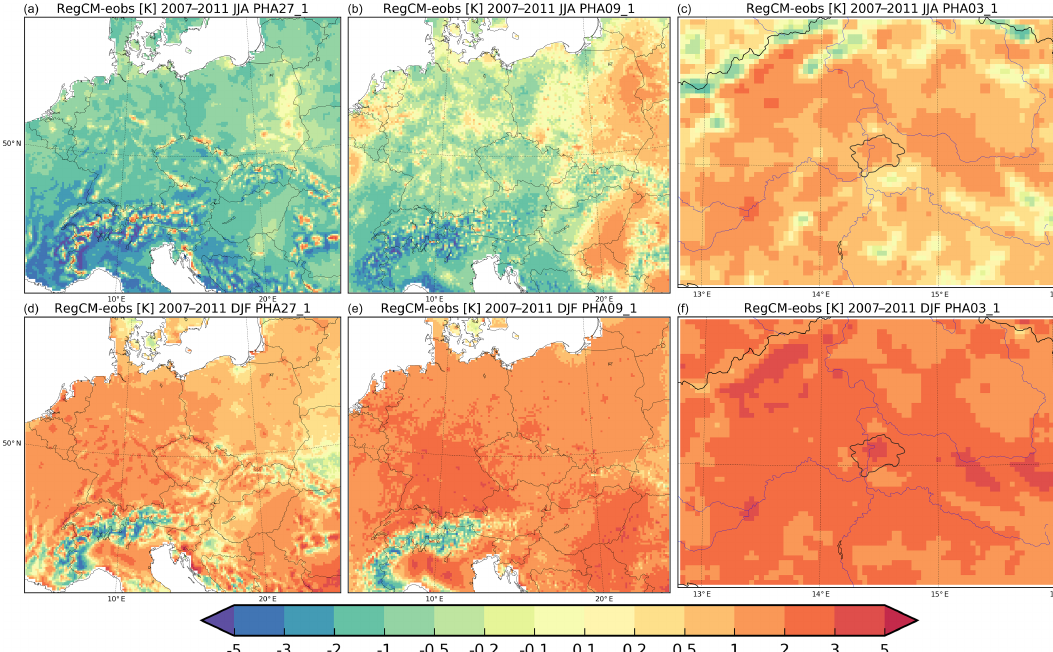
Figure 1. The difference between RegCM model near-surface temperature and E-OBS data for 2007–2011 JJA (a, b, c) and DJF (d, e, f) for the 27, 9 and 3km domains (columns) in ◦ C. Note that the 27km domain is cropped to show only the part corresponding to the 9km domain. For the right panels, the administrative boundary of Prague is indicated too.